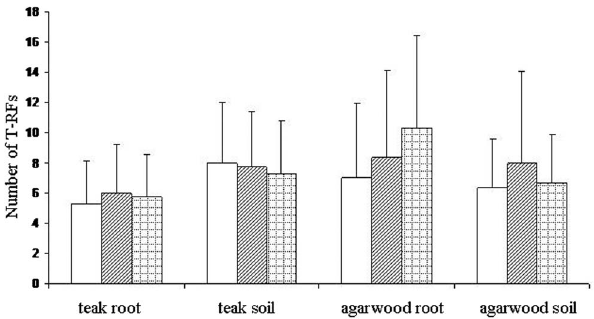
Figure 1. Effects of host plant, Aquilariacrassna (agarwood) and Tectonagrandis (teak), and source of samples (root and soil) on mean number of terminal restriction fragments (TRFs) per sample using three restriction enzymes MboI (open bars), HinfI (hatched bars) and Hsp92II (cross-hatched bars). Values are mean 6 SEM (n=4 for teak and n=3 for agarwood).